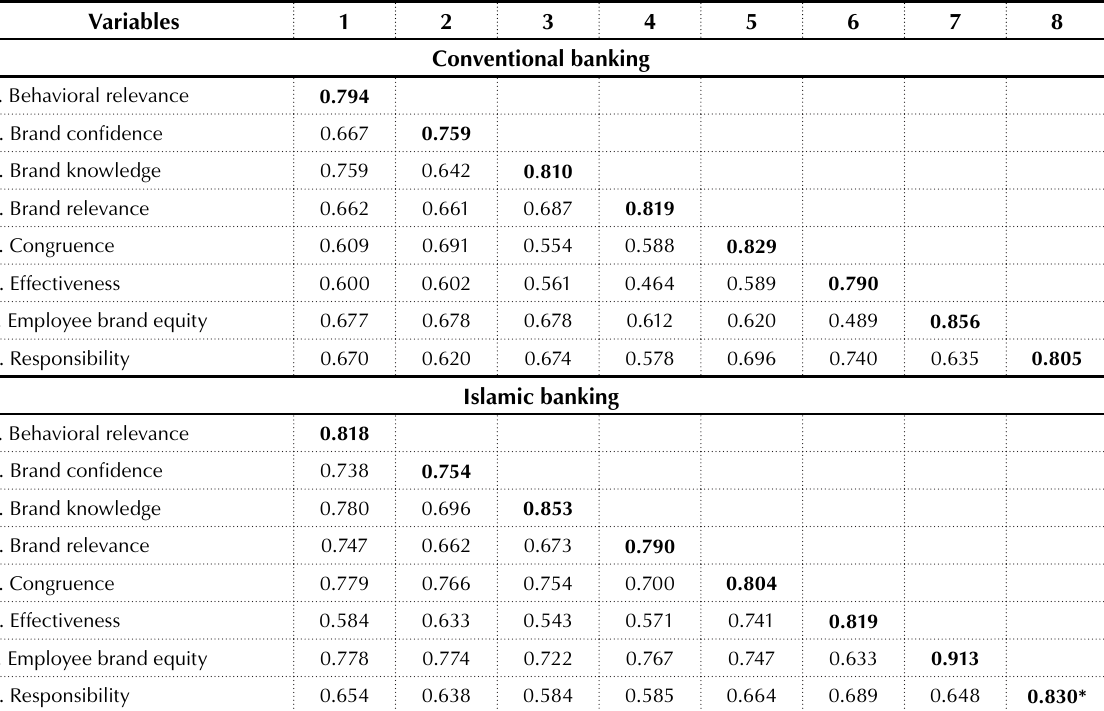
Table 2. Discriminant